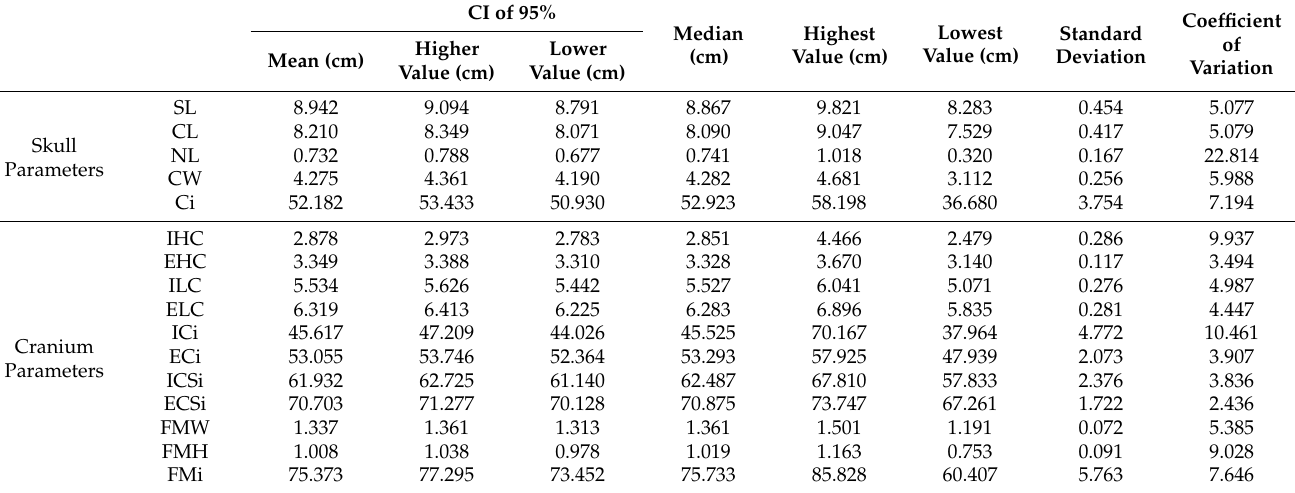
Table 1. Results of the descriptive statistics analysis of the morphometric parameters of the skull and cranium obtained in the population of European shorthair cats.